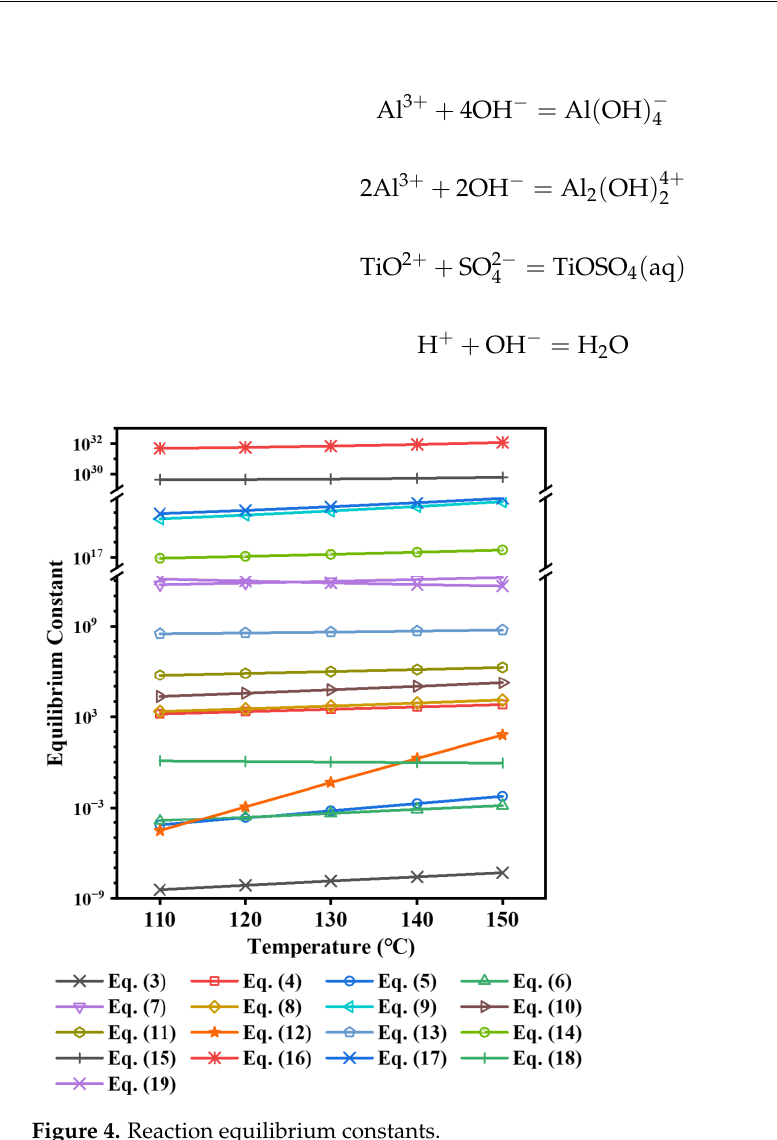
Figure 4. Reaction equilibrium constants.